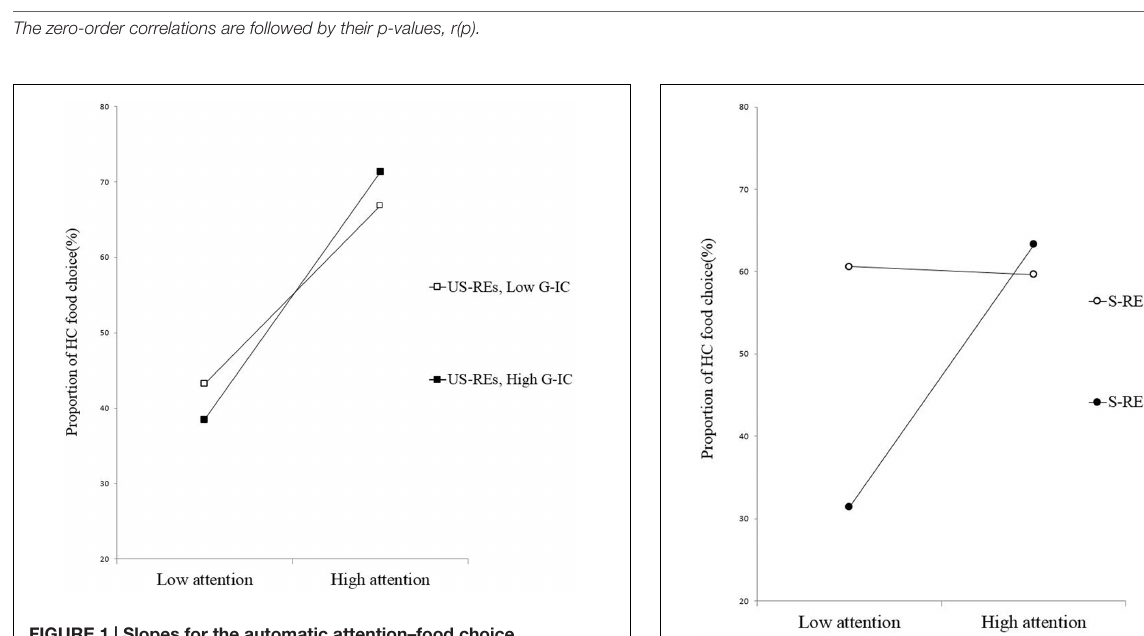
FIGURE 1 | Slopes for the automatic attention–food choice relationship across levels of G-IC among the US-REs.